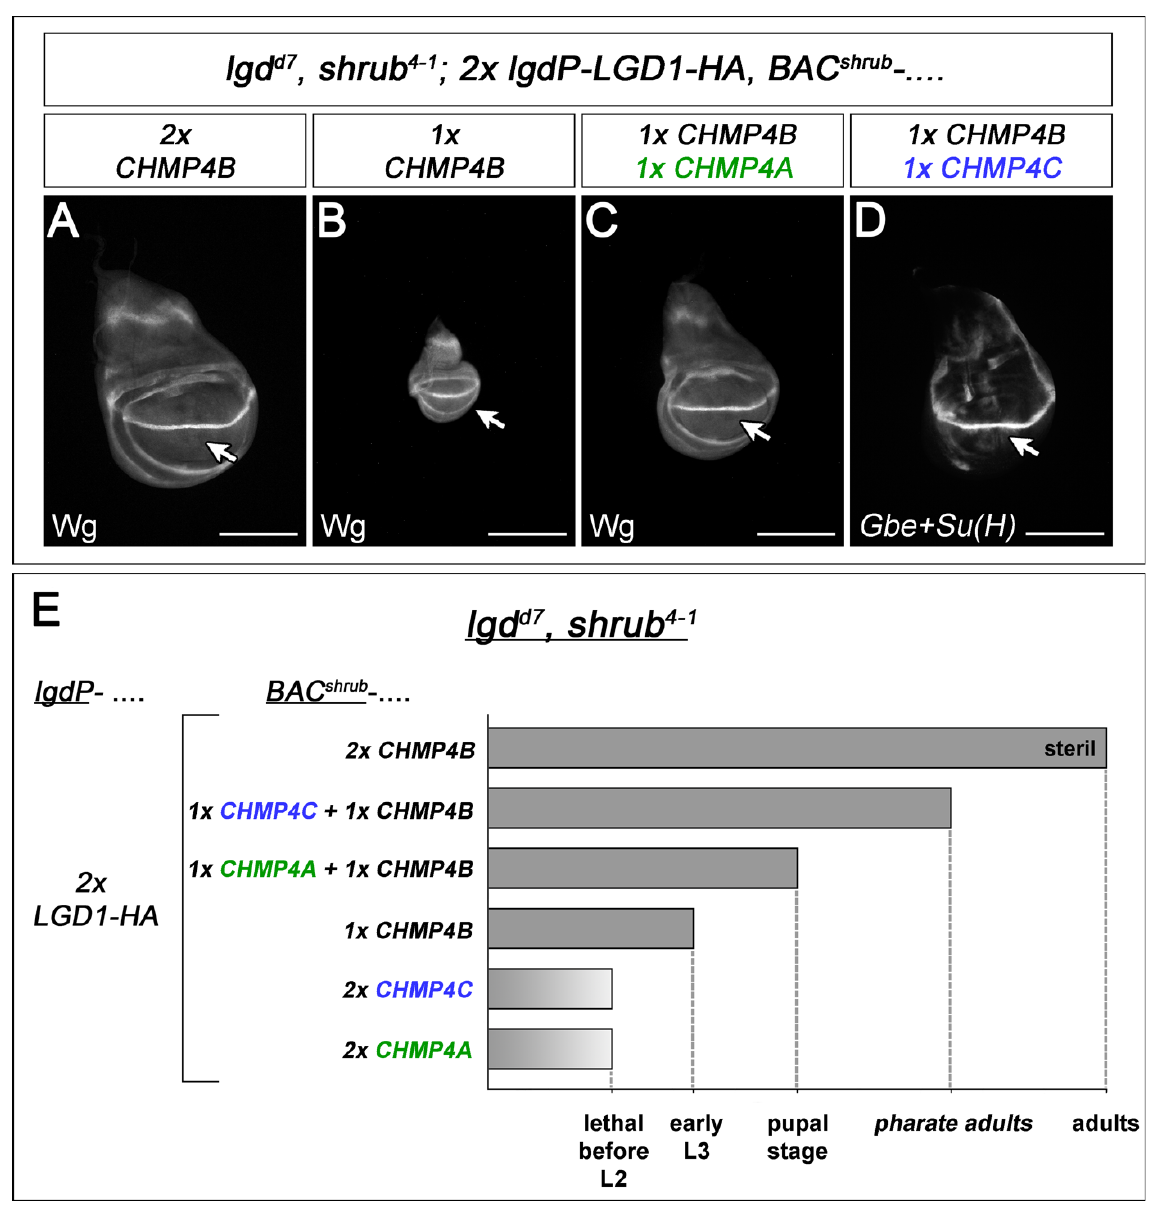
Figure 6. Cooperation between the CHMP4 proteins. Assay to test for the cooperation of CHMP4s is based on the finding that the combination of two copies of lgdP -LGD1 with one copy of BAC shrub - CHMP4B leads to a partial rescue only to the early third instar. The effects of the addition of CHMP4A and CHMP4C to this set up is tested. ( A – D ) The phenotype of disc of different rescue experiments are shown. ( E ) Summary of the rescue experiments. Scale bar ( A – D ) 200 µ m. At least ten wing imaginal discs were analysed for each